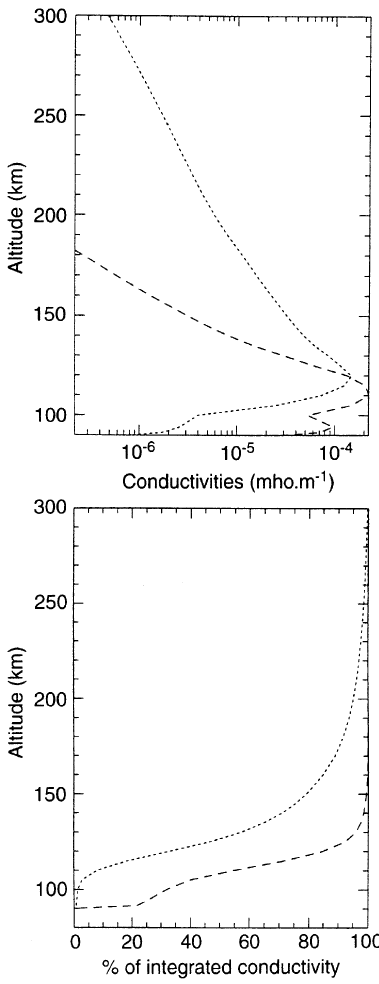
Fig. 4. The panel on the top shows the height profile of the Hall ( dashed line ) and Pedersen ( dotted line ) conductances, obtained by averaging a 12-h run of our model. The bottom panel shows the percentage of explanation of the conductances versus altitude